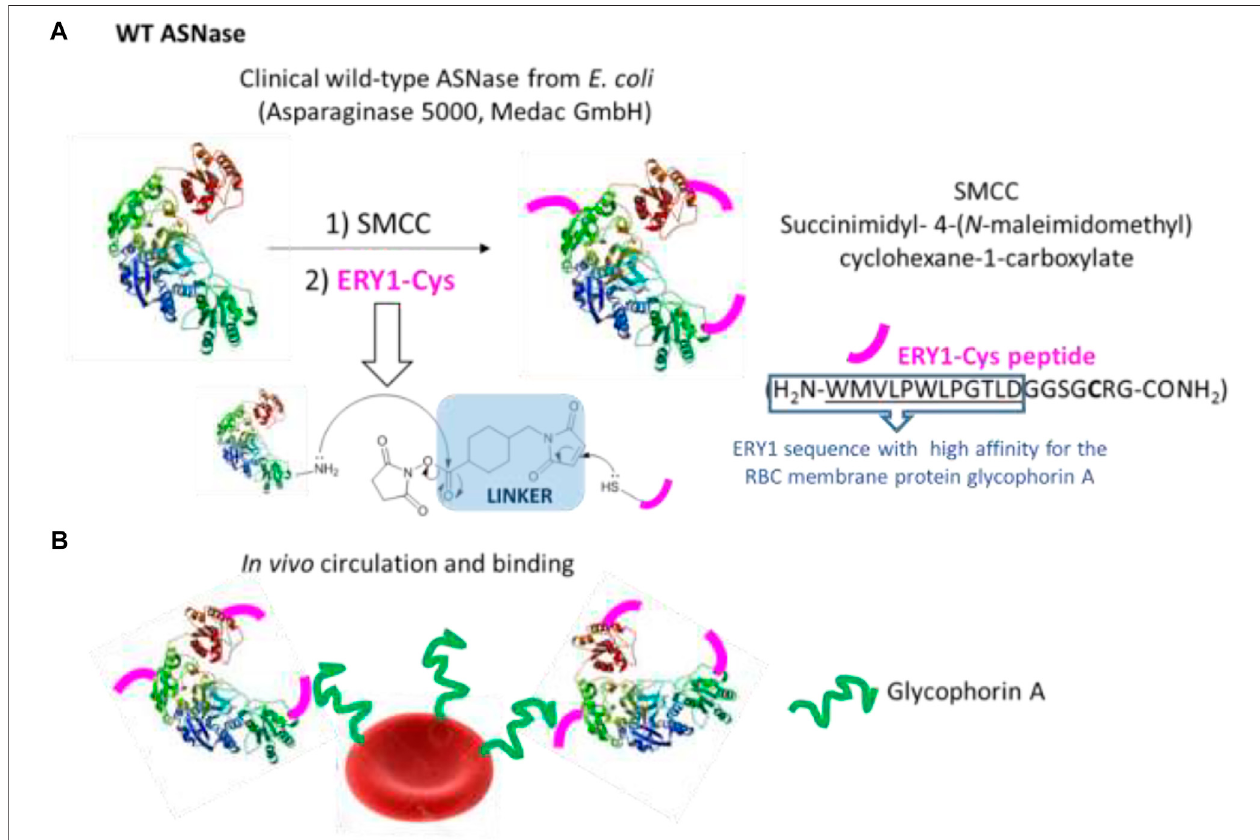
FIGURE 3 | Conjugation of Escherichia coli L-asparaginase-II (ASNase) with copies of glycophorin A-binding peptide (ERY1). (A) Chemical conjugation between Lysresidues ofASNase andpeptideERY1using SMCC asalinker, (B) high-af fi nitybindingofASNasetoerythrocytes throughchemical conjugation ofseveralcopiesof glycophorin A – binding peptide